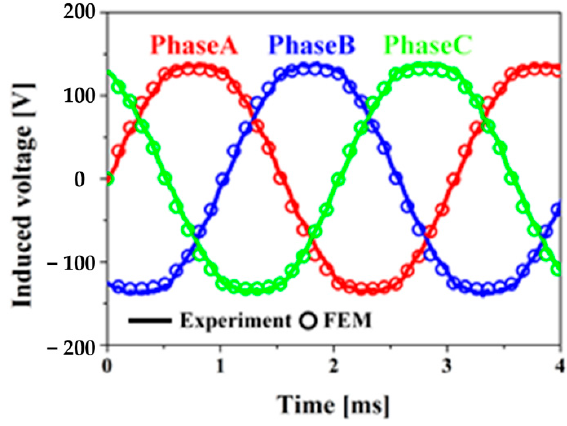
Figure 9. Manufactured initial model and experiment set.